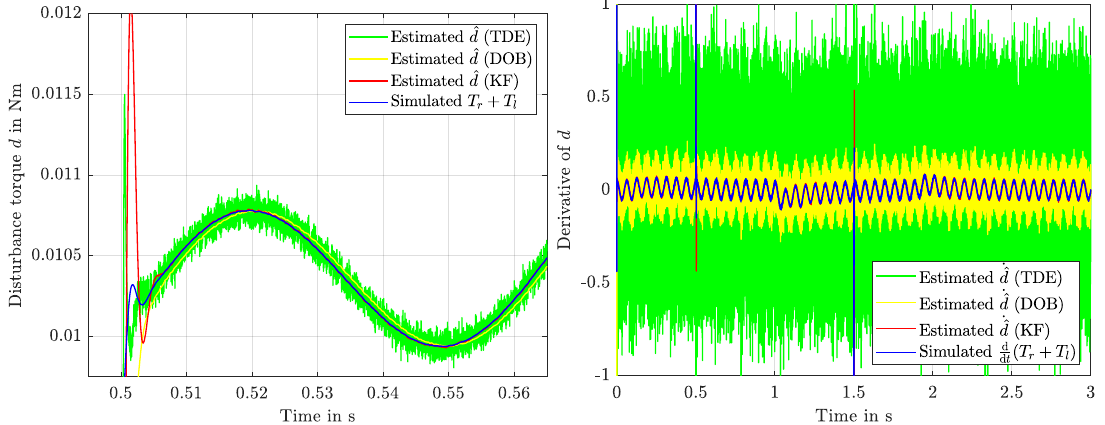
Figure 14. Disturbance estimates for d and ˙ d using KF, DOB and TDE in